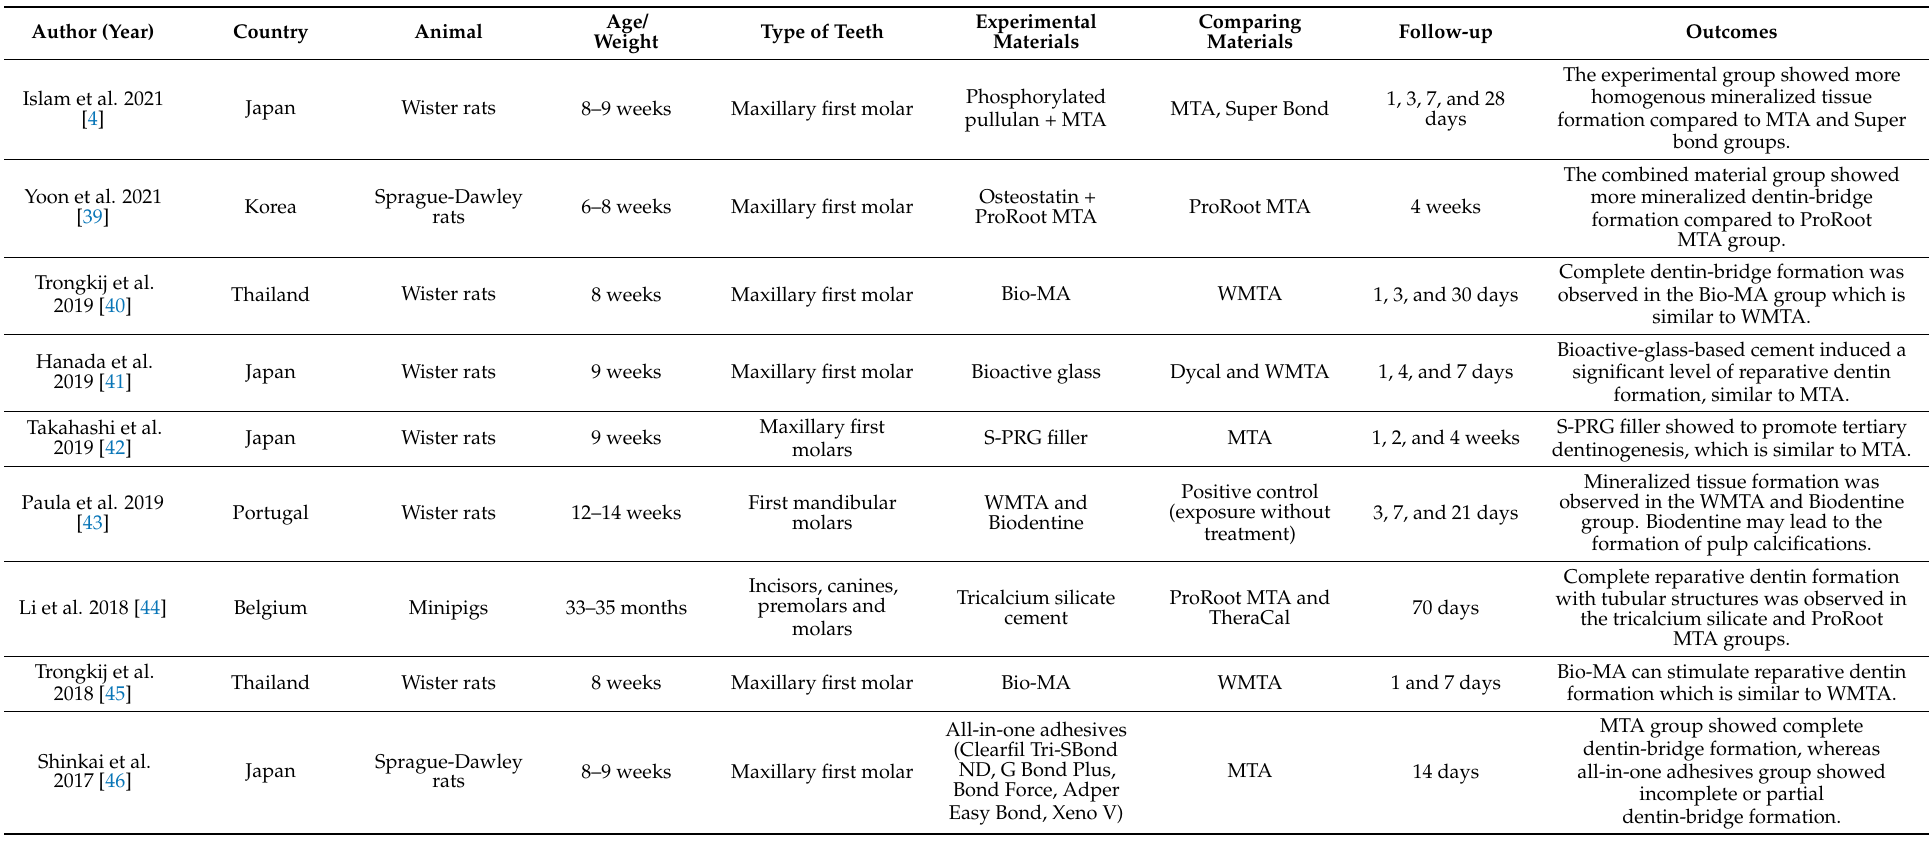
Table 2. Characteristic of the studies included (animals) in the systematic